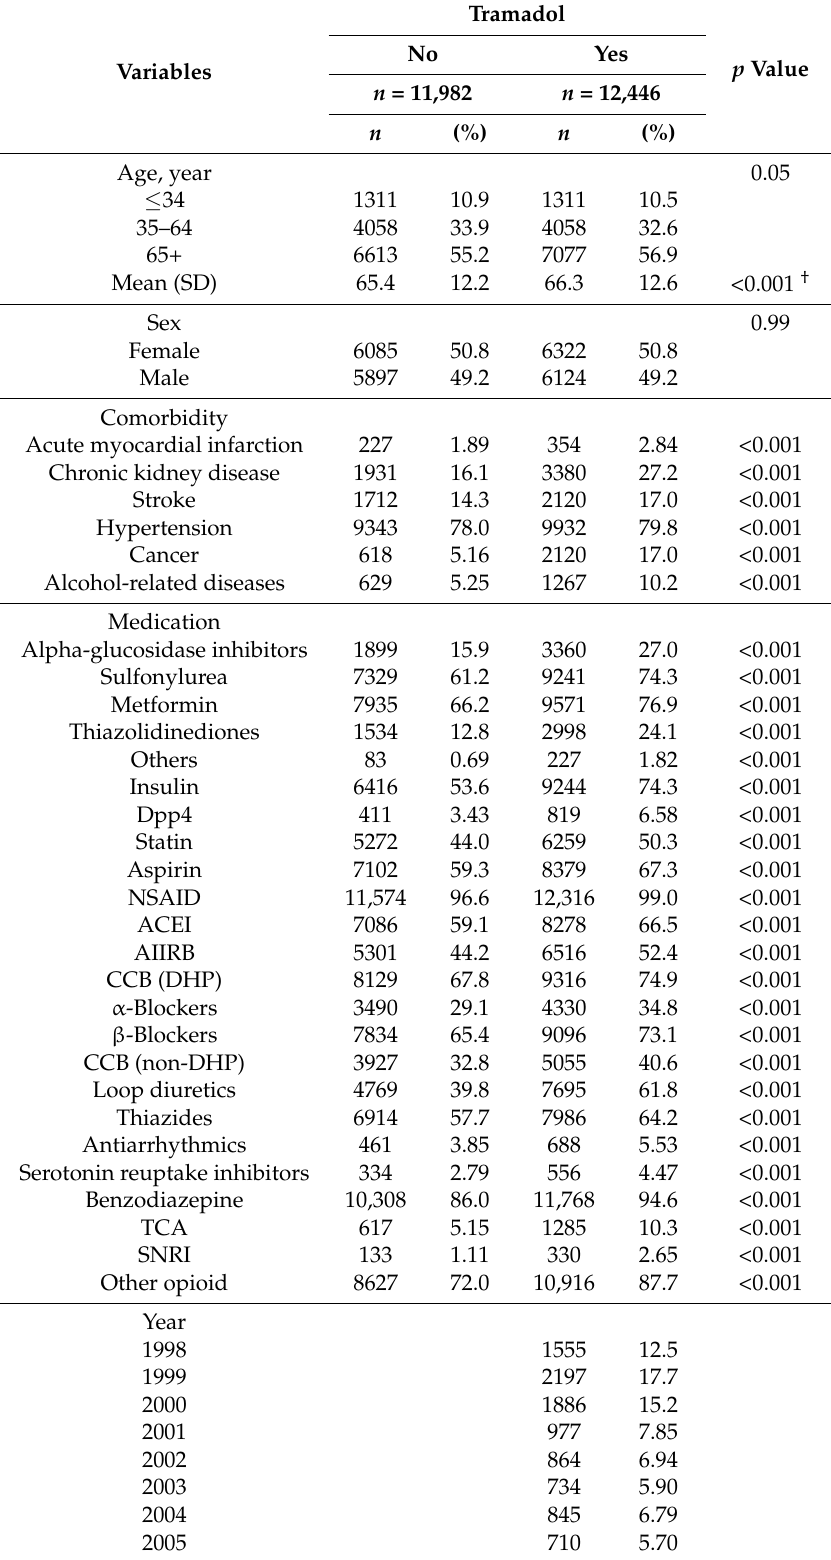
Table 1. Comparison of baseline characteristics between diabetes patients with and without tramadol